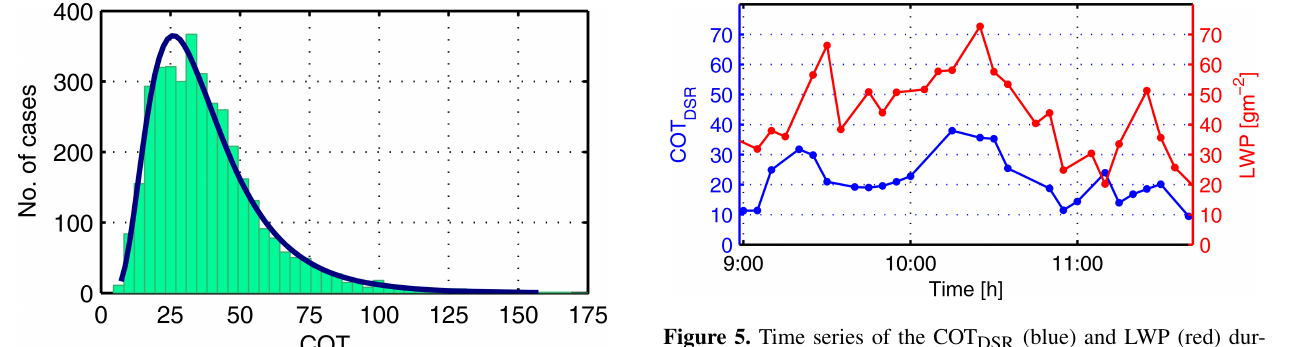
Figure 5. Time series of the COT DSR (blue) and LWP (red) dur- ing St–As conditions in Payerne on 15 March 2015 from 09:00 to 11:45UTC.